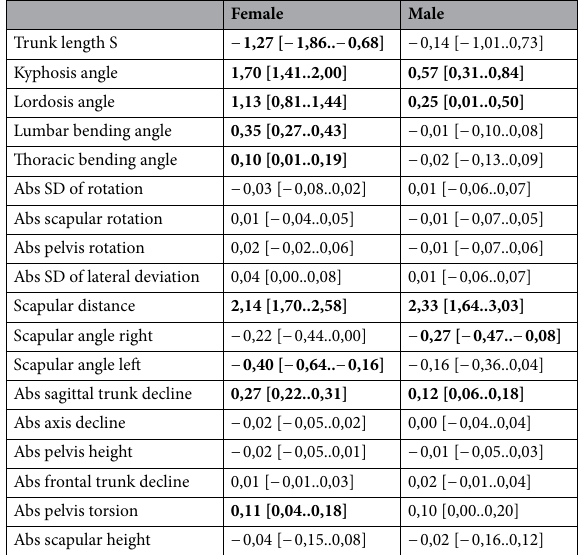
Table 7. BMI dependent regression analysis. Slope of the BMI dependent relationship with the 95% confidence interval of the slope [lower … upper]. If Abs is placed in front of a parameter, only the absolute values are integrated into the calculations, i.e. only the extent without the direction of movement. Significant variables are highlighted in bold.